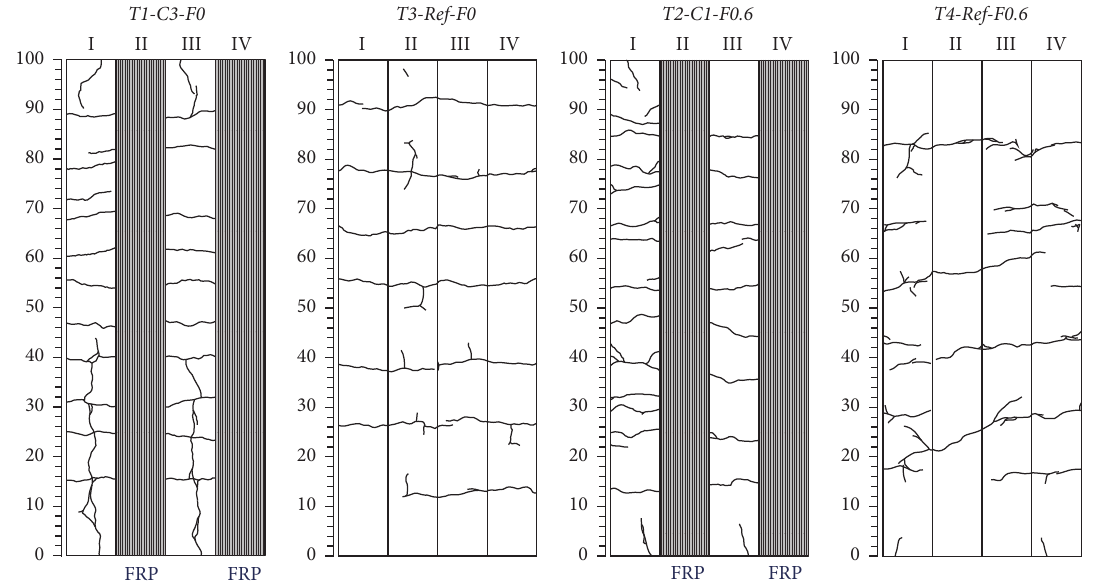
Figure 7: Crack pattern of the ties.